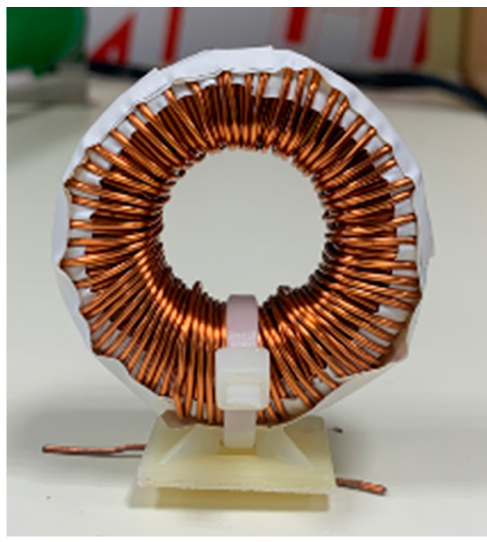
Figure 6. PCB design and building the converter. ( a ) Detail of the connections of the upper layer of the designed PCB, ( b ) 3D recreation of the designed PCB, ( c ) upper face of the built PCB, and ( d ) final assembly of the converter prototype, including LAUNCHXL-F28379D board. Table 3. Characterization of the prototype inductance.